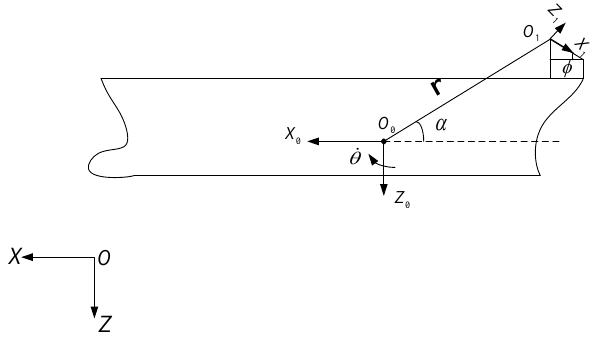
Figure 1. The three coordinate systems are the inertial coordinate system 𝑜𝑥𝑦𝑧 , the coordinate system 𝑜 0 𝑥 0 𝑦 0 𝑧 0 fixed on the ship, and the coordinate system 𝑜 1 𝑥 1 𝑦 1 𝑧 1 fixed on the skid.